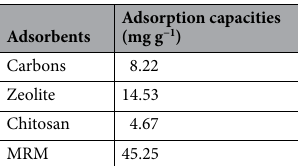
Table 5. Adsorption capacities of different adsorbents for Cd 2+ removal.